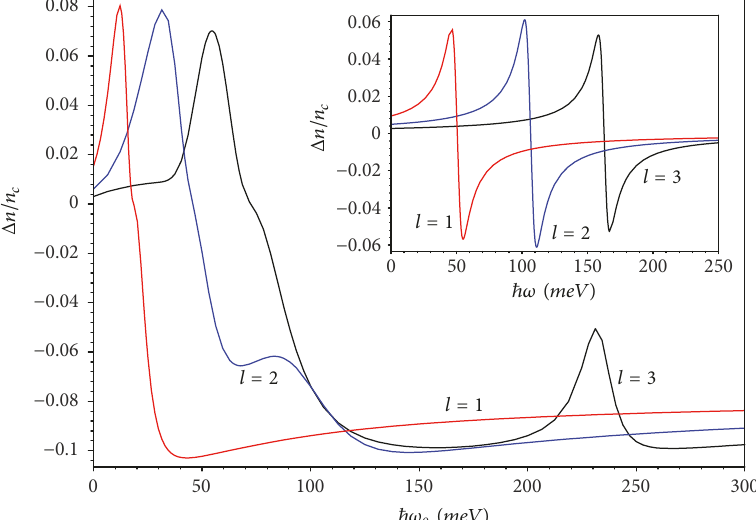
Figure 6: Scaled change in refractive index (CRI) of a CQW as a function of the inverse parabolic potential for the first three radial quantum numbers. The radius is 𝑅 = 100 ˚A and the photon energy remains fixed at ℎ𝜔 = 20 meV. The inset shows the scaled CRI of the cylindrical quantum wire as a function of the photon energy for the first three radial quantum